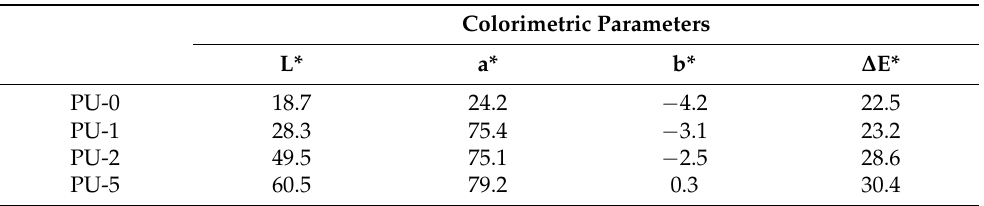
Table 9. Color analysis of PUR foams after UV aging, where ∆ E*—total color change, L*—degree of lightness, a*—red/green parameter, b*—yellow/blue parameter.